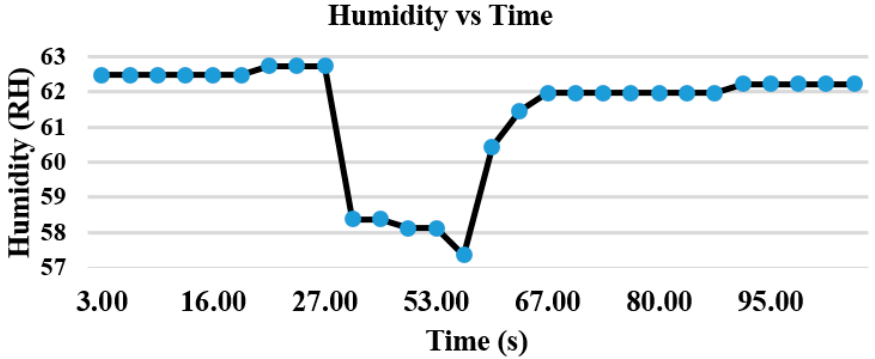
Figure 6. The recorded light sensor voltage level resultant from this fire hazard event.